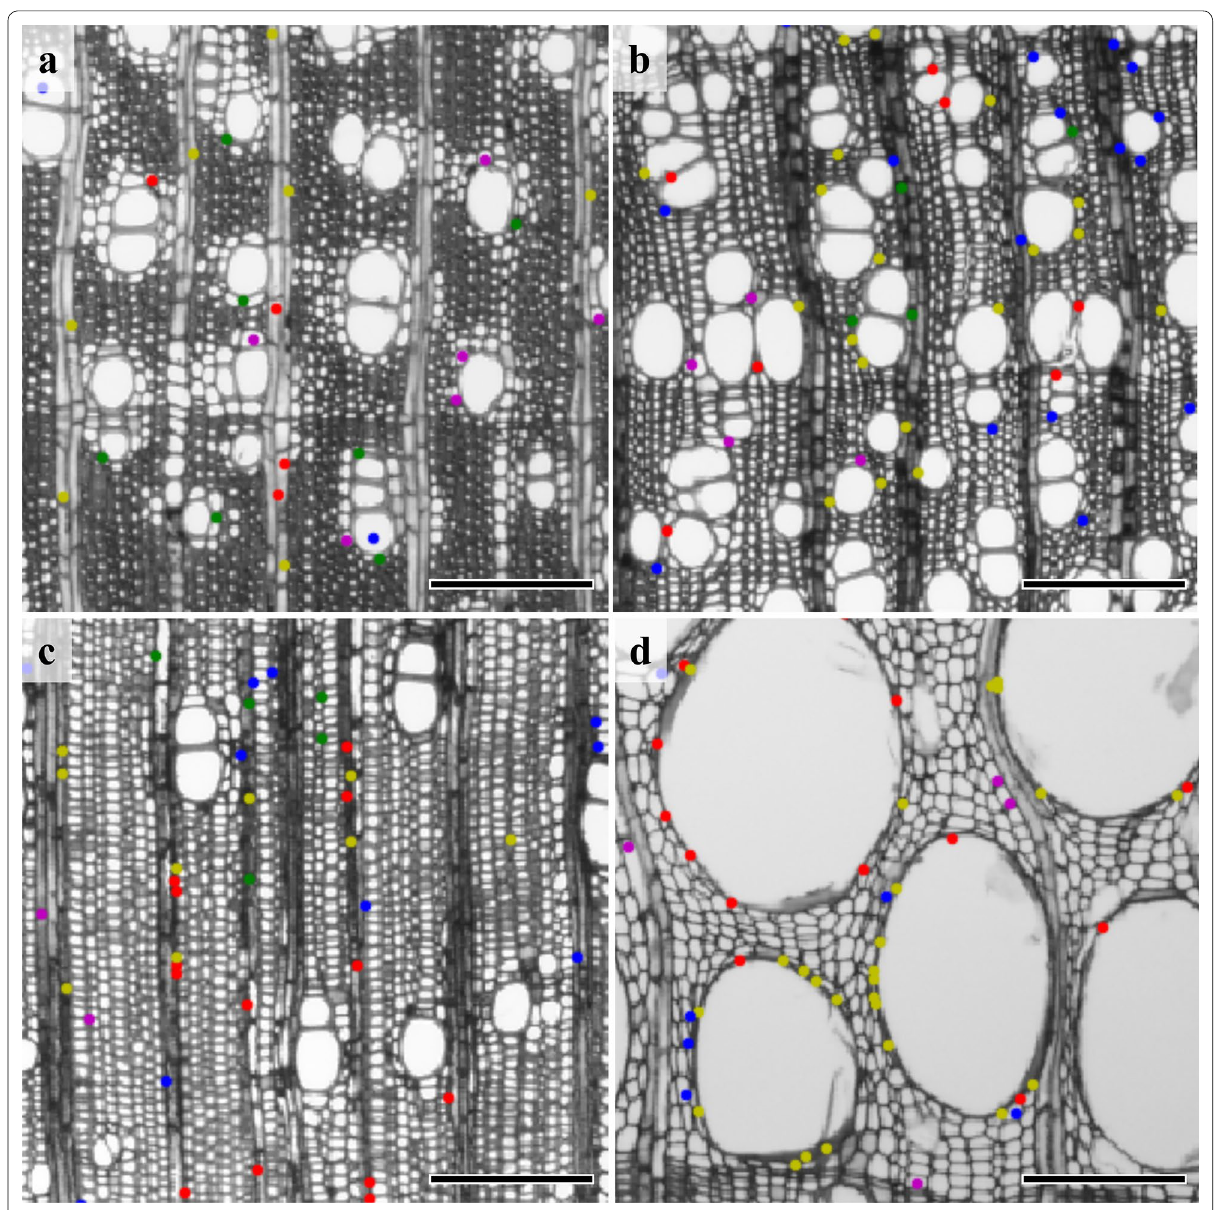
Fig. 5 Visualization of SIFT keypoints belonging to the five codewords with the highest TFIDF scores from Lindera glauca ( a ), Lindera umbellata ( b ), Laurus nobilis ( c ), and Sassafras tzumu ( d ). The images show an enlarged part of the original images, and the scores run from high to low in the order red, yellow, green, blue, and purple. Scale bars 200